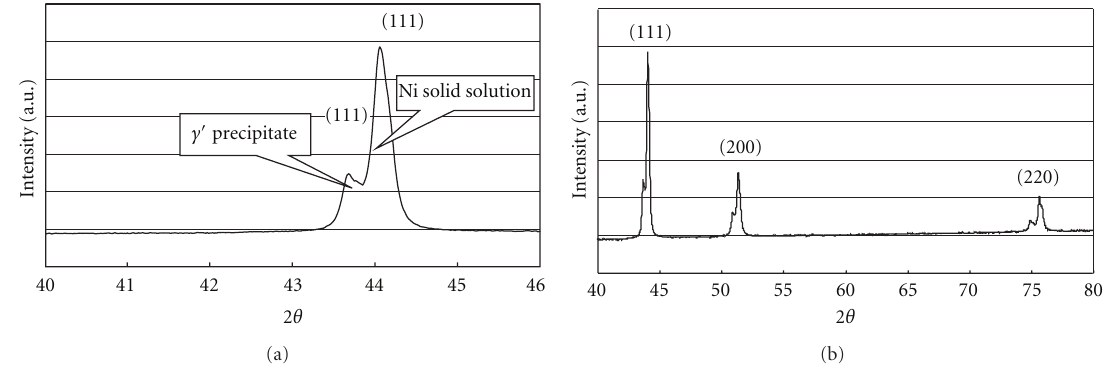
Figure 3: Results of X-ray di ff raction for Ni-15at%Al (MA) after aging at 800 ◦ C.